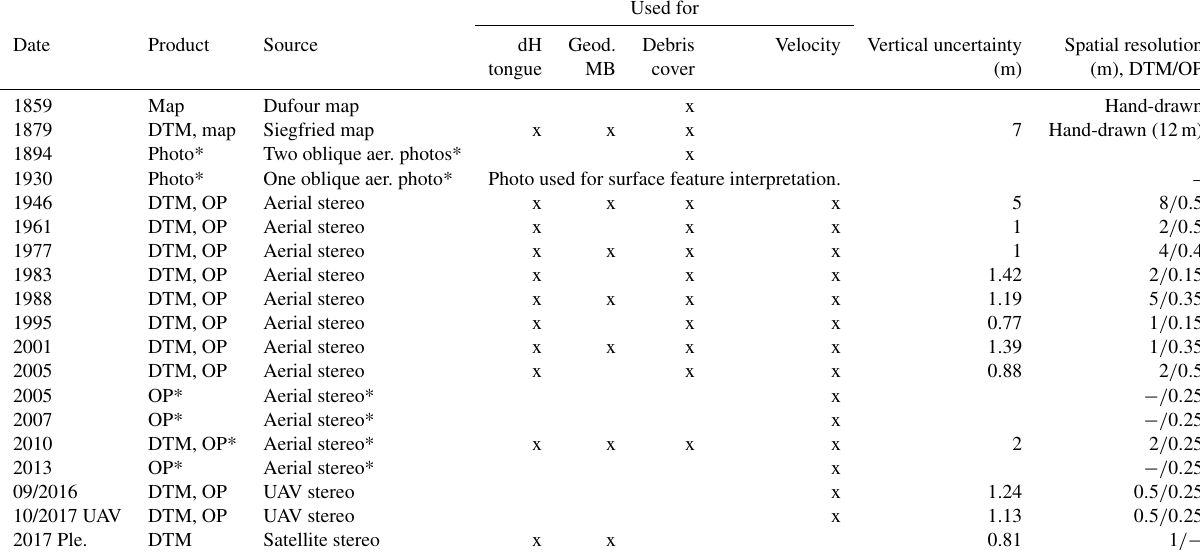
Table 1. Topographic maps and satellite and aerial images used in this study. Abbreviations are as follows: dH: elevation change; DTM: digital terrain model; OP: orthophoto; obl. aer.: oblique aerial; Ple.: Pleiades. Entries denoted with an asterisk are used as a final product. All data except 1894, 2016, and 2017 are from Swisstopo (2018a). Oblique photos from 1894 were taken by Reid